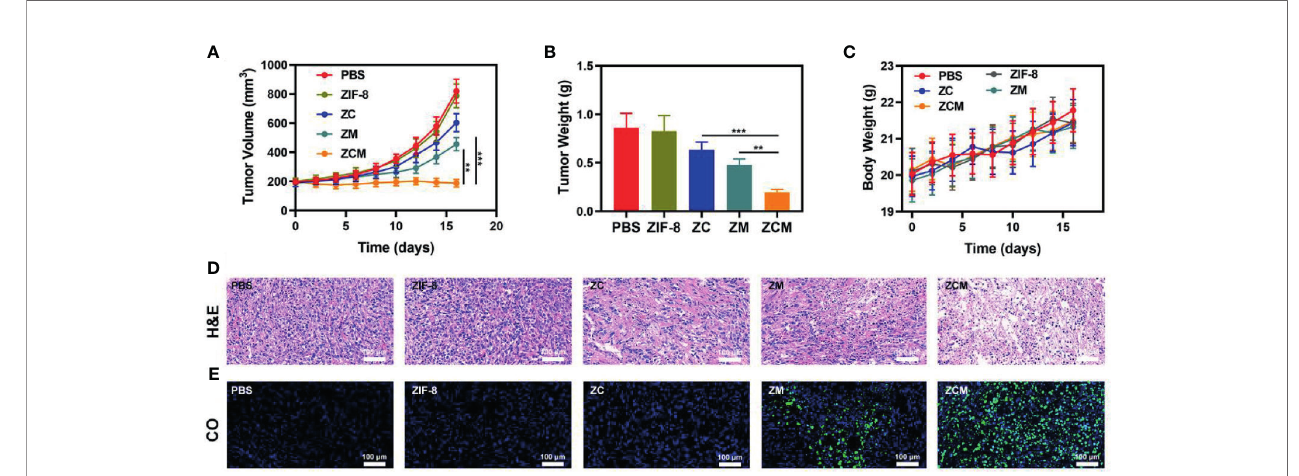
FIGURE 3 | In vivo therapy. (A) Tumor volume, (B) weight, and (C) murine body weight were monitored in the fi ve treatment groups (n = 5). (D) Tumor sections were stained for H&E. (E) Fluorescence imaging for co-localization of the tumor region to test CO production. (Blue: DAPI, green: FL-CO-1). **p < 0.01, ***p < 0.005; Student ’ s